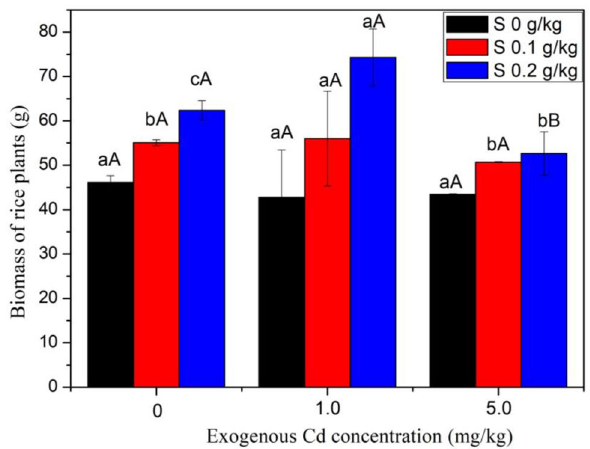
Figure 1. The effect of S application on biomass of rice plant. Different lowercase letters within biomass for rice indicates a significant difference among different S levels at P < 0.05. Different capital letters within biomass for rice indicates a significant difference among different Cd treatments at P <